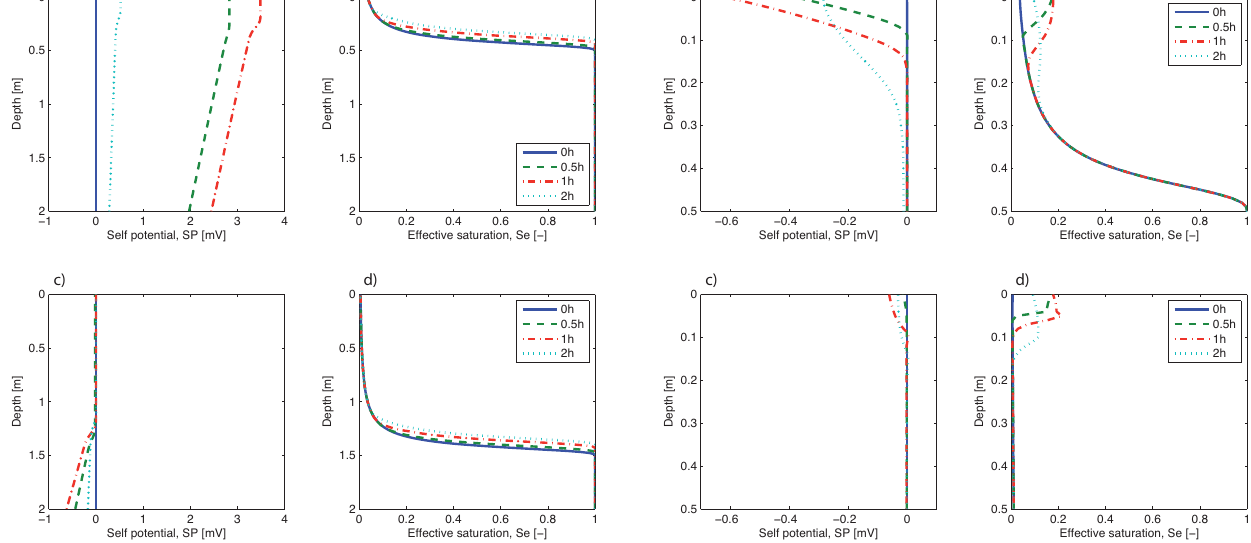
Fig. 8. (a) Variation of the modeled SP signal with depth at dif- ferent times for a rising water table (10cmh − 1 during 1h) located at (a) 0.5–0.4m and (c) 1.5–1.4m depth (see Fig. 7). (b) and (d) Corresponding values of the effective water saturation.